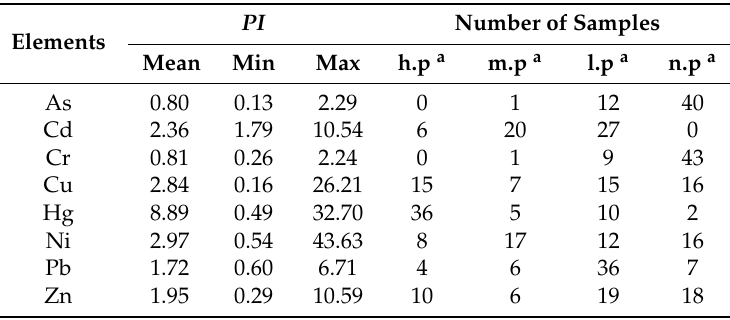
Table 6. Statistical results of pollution index ( PI ) of heavy metals in topsoils around industrial sites in Dongguan. PI Number of Samples Elements Mean Min Max h.p a m.p a As